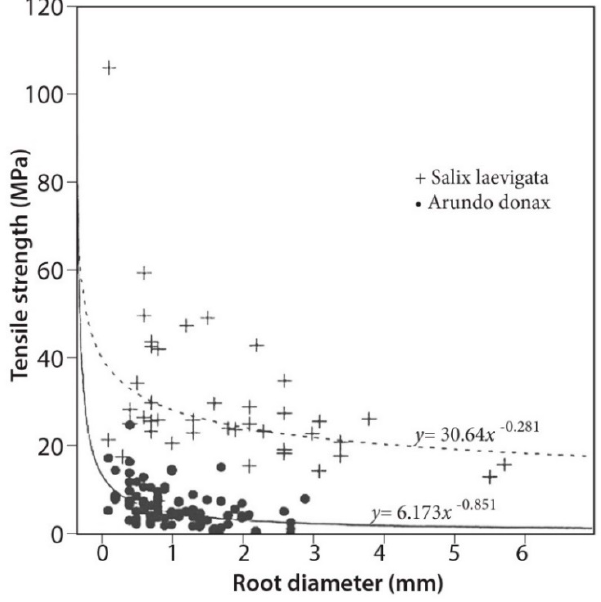
Figure 12. Regression of root diameter (mm) to tensile strength (MPa) for both A. donax and S. laevigata. S. laevigata is the top equation and A. donax is the bottom equation.